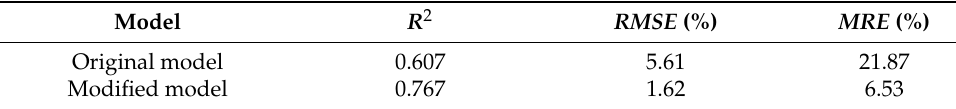
Table 3. The comparation of the original and modified model.